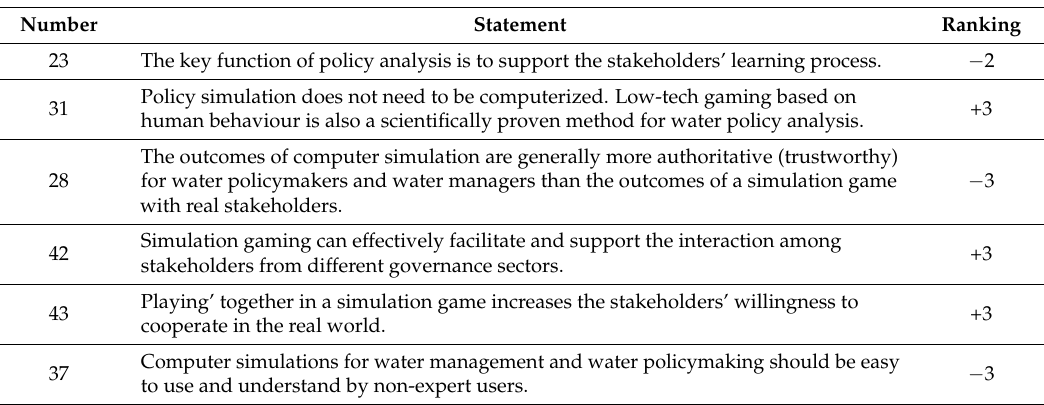
Table 4. Distinguished statements about MSG in frame